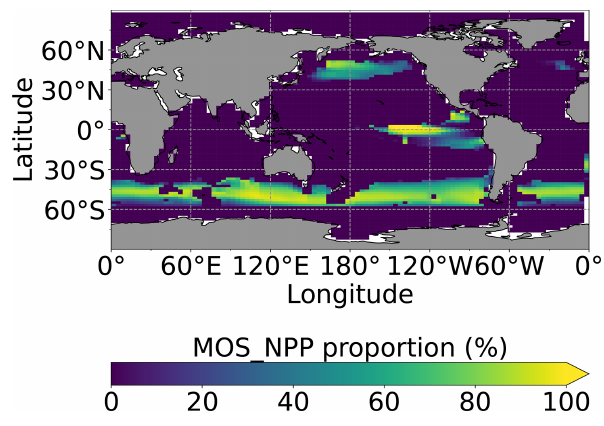
Figure 8. Proportion of MOS NPP in the global oceanic NPP by year 2100 (MOS_NPP / (MOS_NPP + PNPP) × 100). Note that the NPP values are converted to carbon using the respective C : N ra- tio. The MOS_NPP generally amounts to more than 70% of total oceanic NPP where MOS is deployed, indicating an obvious NPP shift from phytoplankton PNPP to